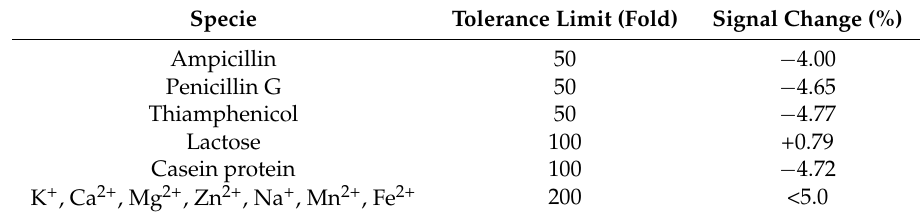
Table 2. Result of interference studies for the detection of Amoxicillin (10 µ M) at optimum